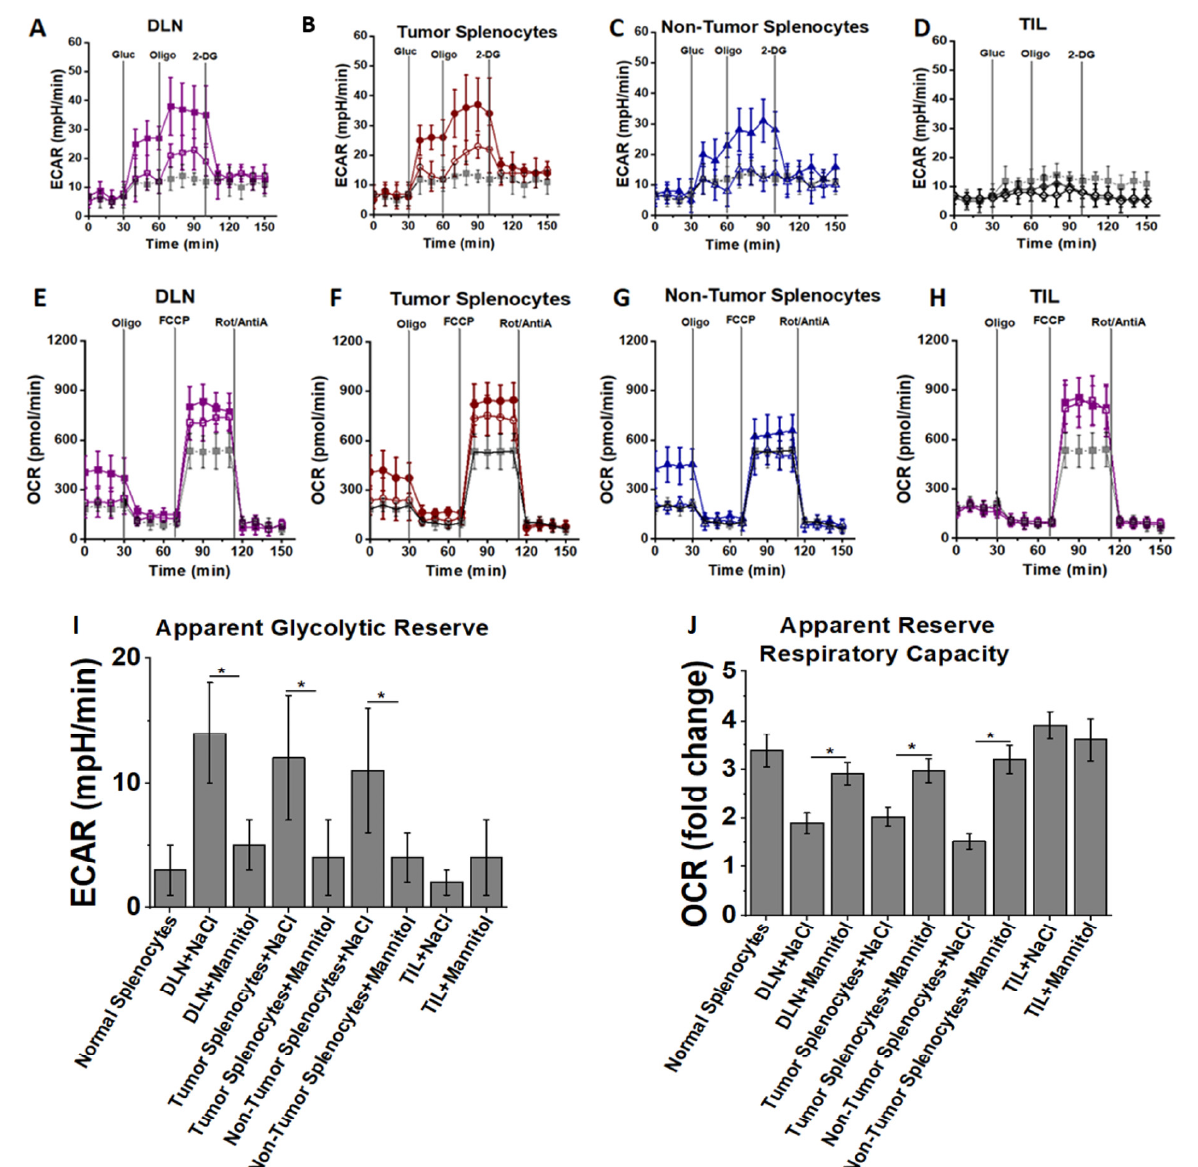
Figure 6. High salt induces metabolism with unique oxidative fuel capacity. CD4+T cells obtained from DLNs ( A , E ), tumor splenocytes ( B , F ), non-tumor splenocytes ( C , G ) and TILs ( D , H ) at the end of third stimulation cycle (day 21) were cultured in base DMEM media without glucose and glutamine. Extracellular acidification rate (ECAR) ( A – D ) was assessed by time-course changes in lactate production after the addition of 25 mM glucose (gluc) and in response to the metabolic inhibitors oligomycin (oligo) and 2DG. For oxygen consumption rate (OCR) ( E – H ), cells at the same stimulation cycle mentioned above were cultured in base DMEM media with 25 mM glucose for basal OCR response, followed by time-course response changes with addition of mitochondrial inhibitors oligomycin, FCCP, and rotenone and antimycin A (Rot/AntiA). Apparent glycolytic reserve ( I ) calculated from ECAR analysis and apparent reserve respiratory capacity ( J ) calculated from OCR are shown. Data obtained from 5 independent measurements and presented as mean ± SEM; (*) p <